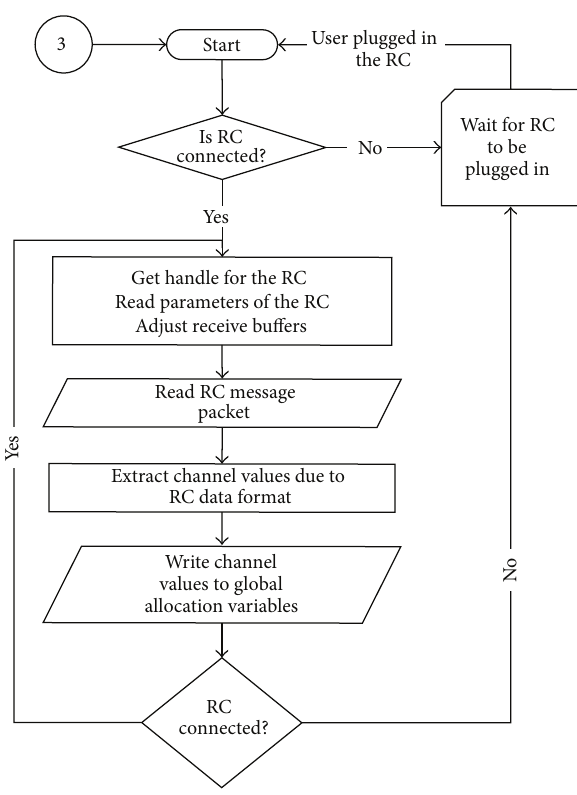
Figure 5: RC guidance device interface